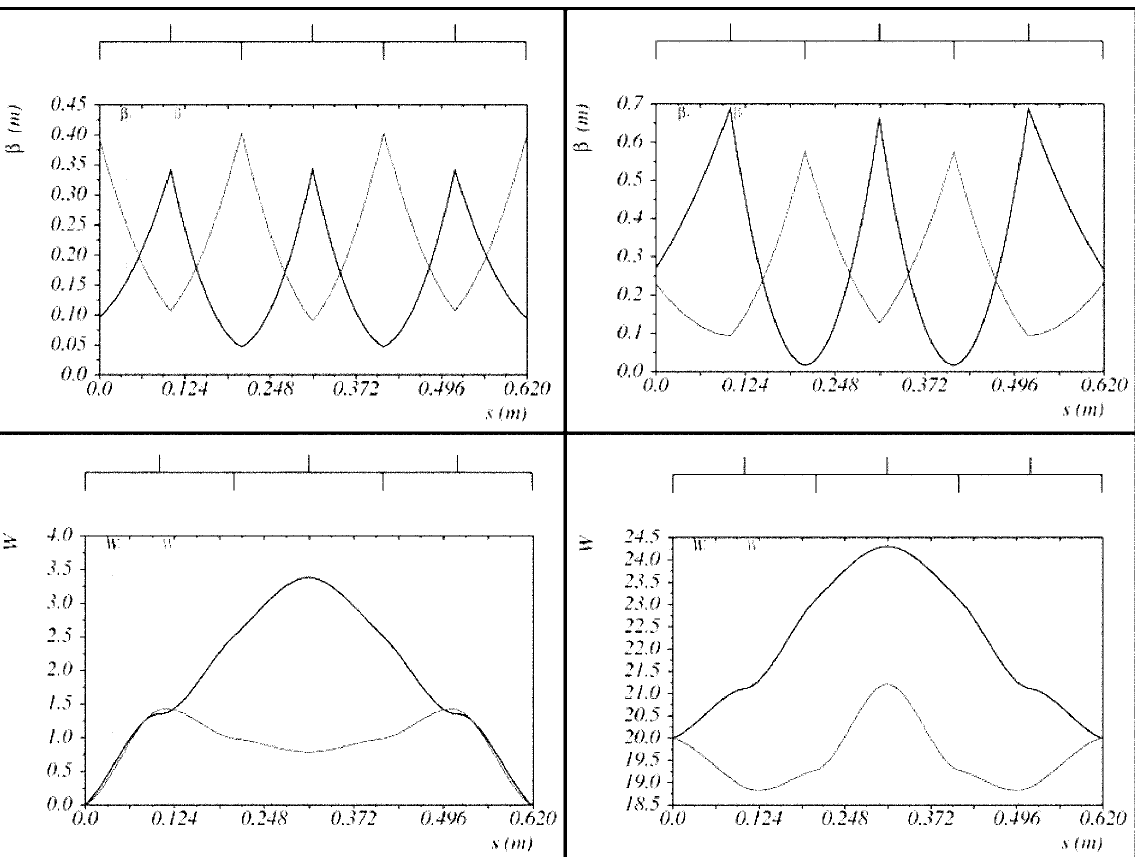
FIG. 7. Lattice parameters for a simple chromatic, conditioning beam line. The left-hand plots show the ‘‘matched’’ case, and the right-hand plots the ‘‘mismatched’’ case. Black lines correspond to the horizontal plane, red lines to the vertical plane. Top: Beta functions. Bottom: Variation of the above beta functions with energy, expressed in terms of the W